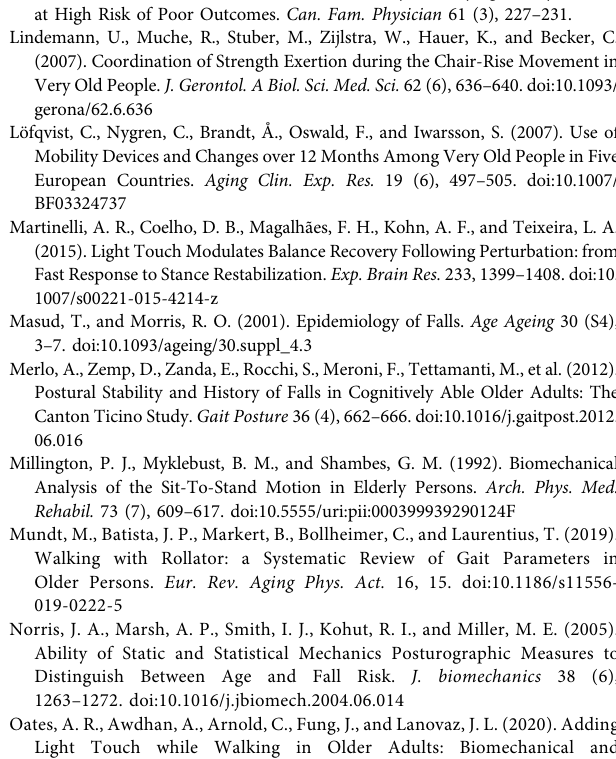
Figueiredo Lopes, V. (2020). Sit-to-stand Activity to Improve Mobility in Older People:AScopingReview. Int.J.Older People Nurs. 15(3),